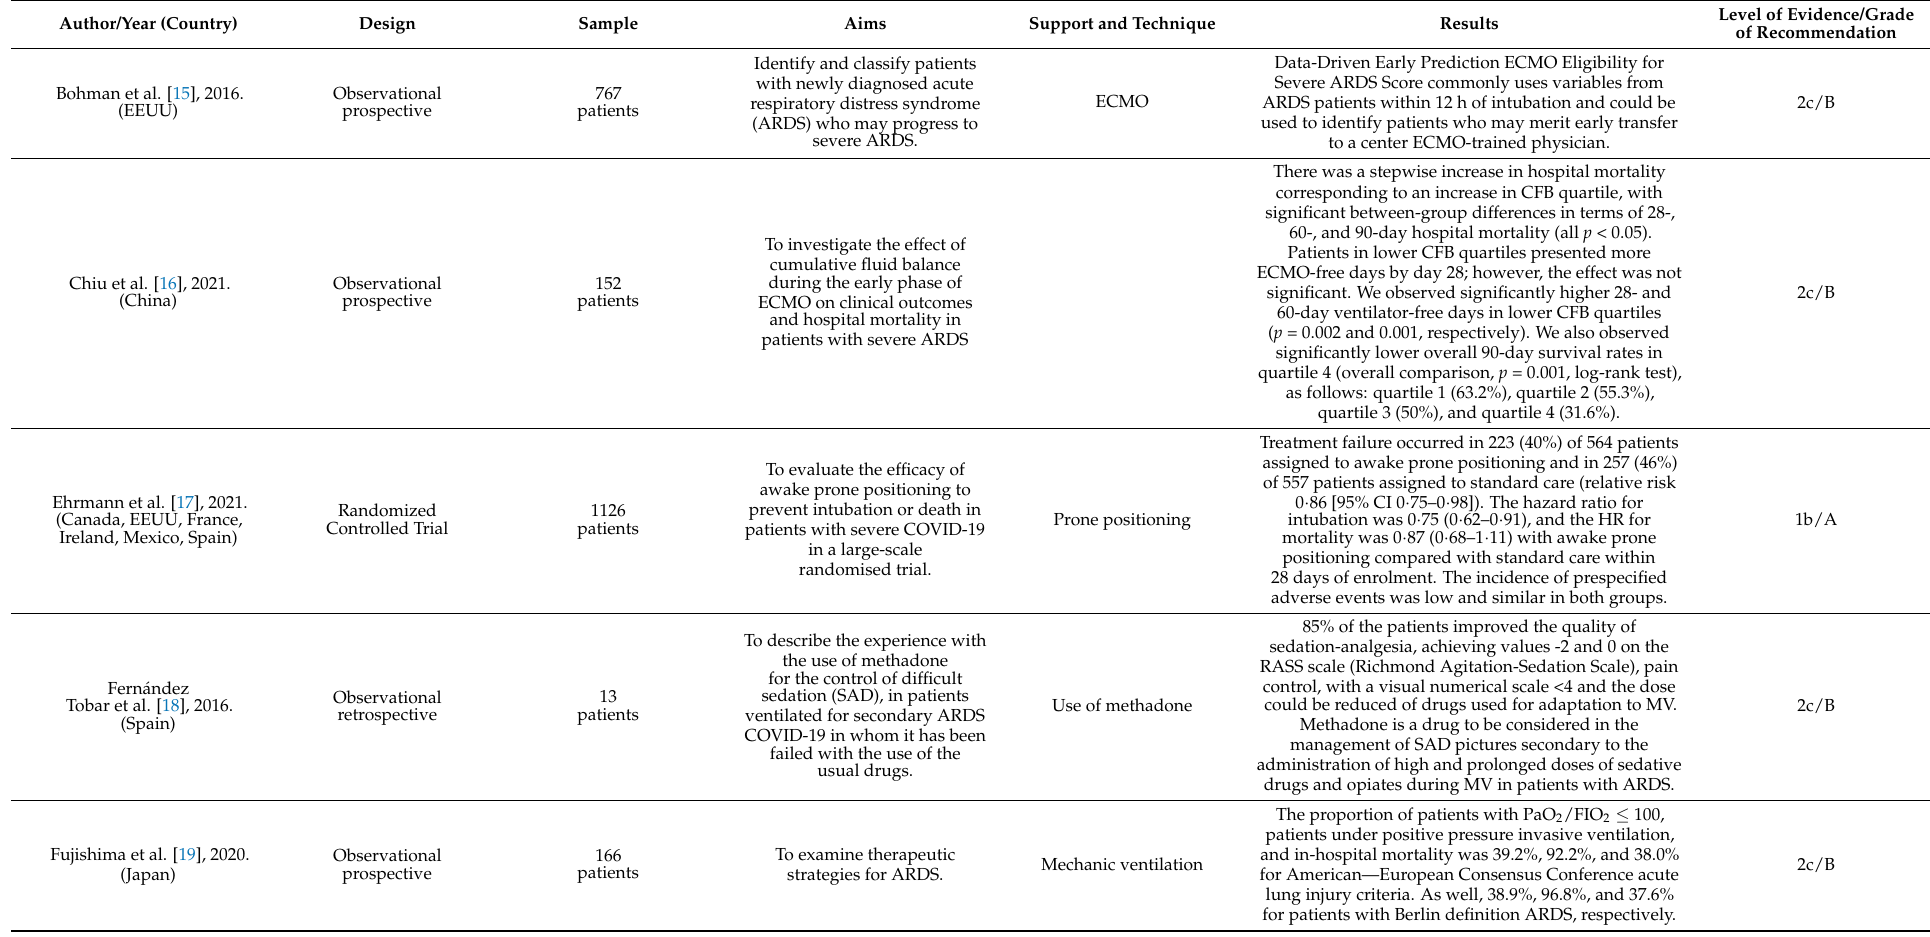
Table 1. Characteristics of the selected